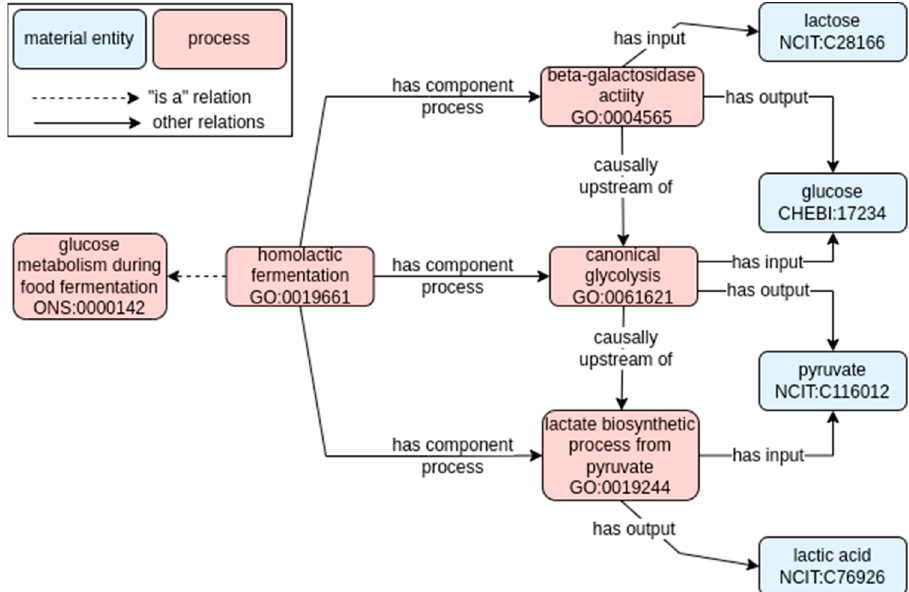
Figure 2. Ontological model of glucose metabolism involved in dairy fermentation. Solid arrows represent semantic relations in RO (annotated with their label), while dashed arrows represent hierarchical relationships (i.e., “is a” relation). Pink and blue rectangles refer to process or material entity, respectively. The label and the term ID (formatted as an ontology prefix followed by a number) are reported for each class.